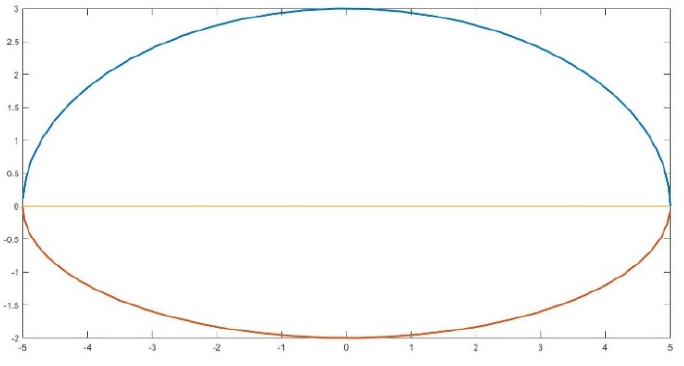
Figure 39. Horizontal section of a Pterasphera of major axis 10 and minor 5.